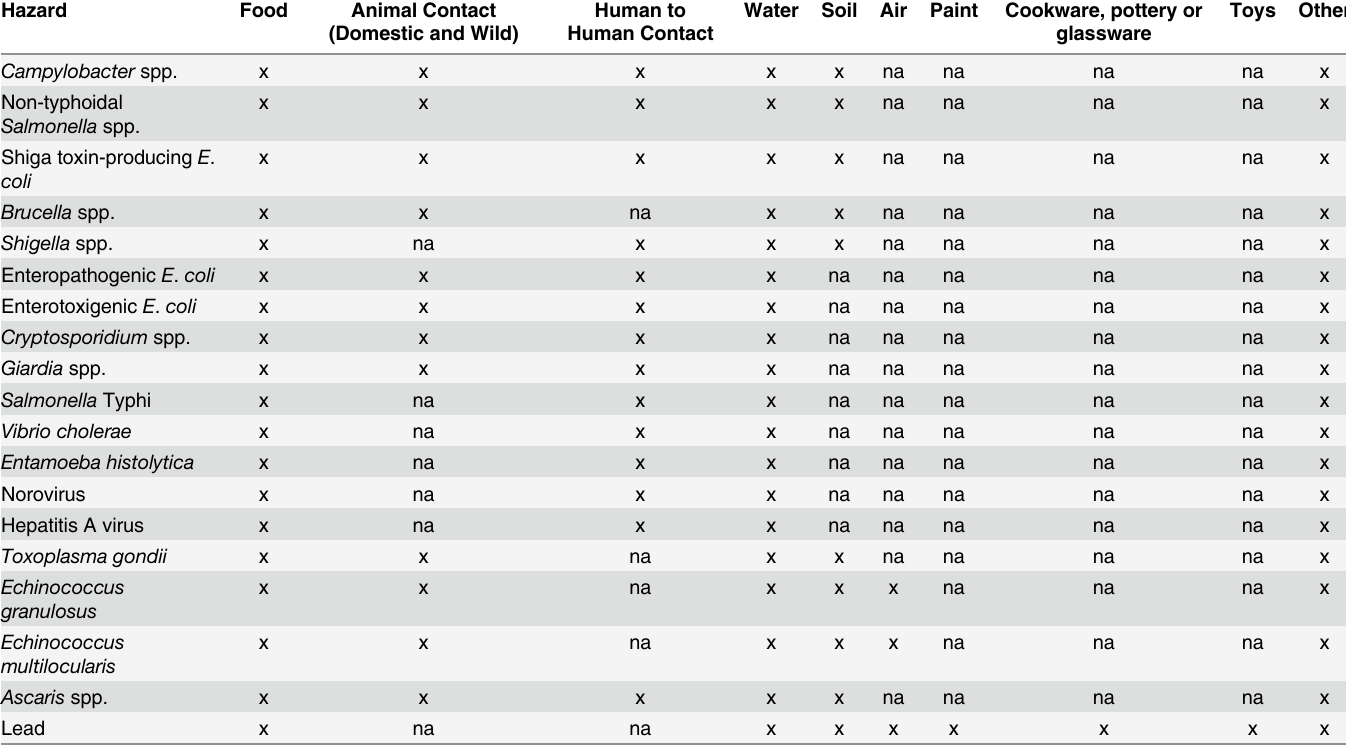
Table 3. Exposure routes included in the expert elicitation. Hazards were grouped according to common exposure routes. na: not applicable, meaning that these exposure routes were considered not possible or extremely unlikely by the respective FERG task